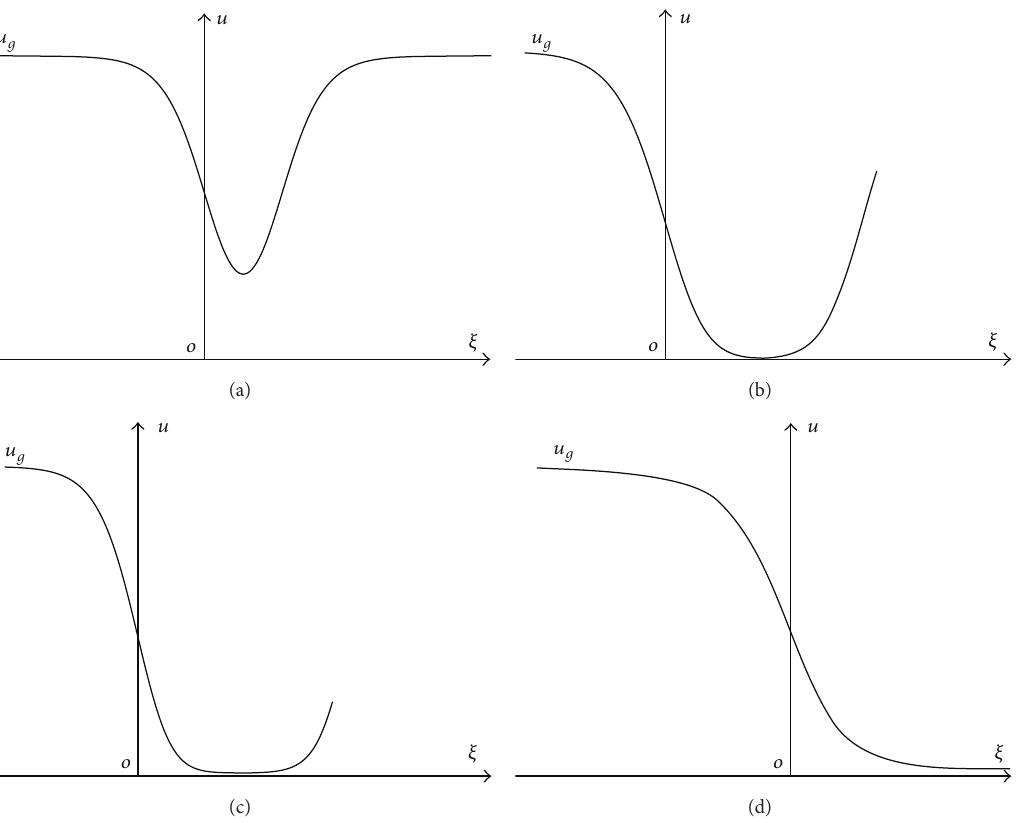
Figure 12: (The antikink wave is bifurcated from the valley-shape solitary wave). The varying process for the graph of 𝑢 𝑔 when 𝑐 > 0 , 𝛿 > 0 , 𝑎 > 0 , and 𝑏 → −16𝑎 2 /75𝑐−0 , where 𝑐 = 1 , 𝛿 = 1 , 𝑎 = 1/2 , and (a) 𝑏 = −16𝑎 2 /75𝑐−10 −3 . (b) 𝑏 = −16𝑎 2 /75𝑐−10 −7 . (c) 𝑏 = −16𝑎 2 /75𝑐−10 −8 . (d) 𝑏 = −16𝑎 2 /75𝑐 − 10 −10 .